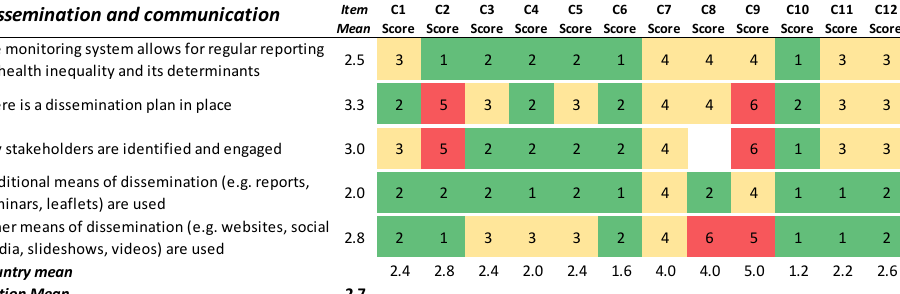
Figure 3. Results for the section ‘Analyses’. Green cells (scores 1–2) indicate agreement with the statement. Yellow cells (scores 3–4) indicate partial agreement/disagreement, and red cells (scores 5–6) indicate the most challenging preconditions for an ideal HIMS.